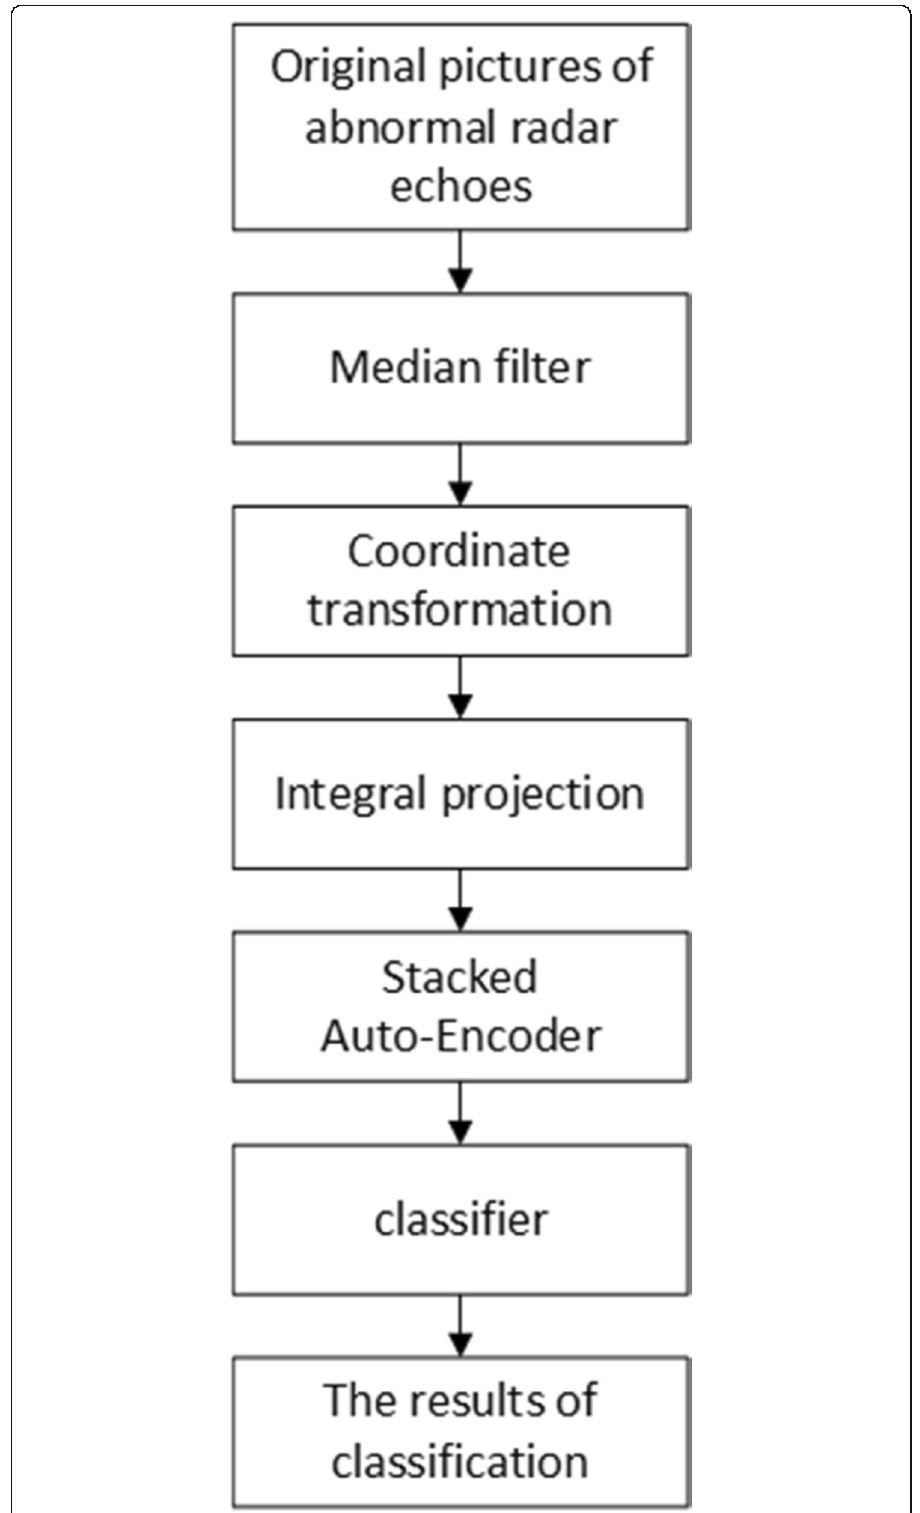
Fig. 2 Flow chart of proposed